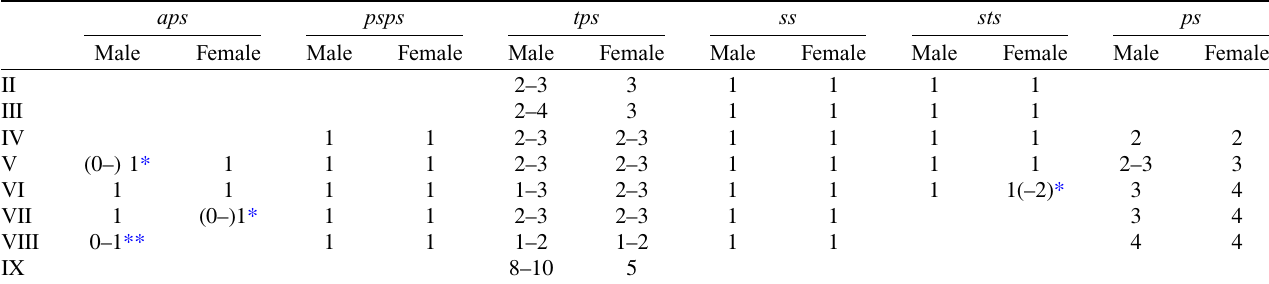
Table 2. Chaetotaxy of one side of abdominal segments II – IX of male and female of Sturnidoecus from Turdus merula collected in the Azores, 2013 . Trichoid setae of segment VIII are present in all specimens, and are not listed. Abbreviations: aps = accessory post-spiracular seta; psps = principal post-spiracular seta; ps = paratergal seta; ss = sutural seta; sts = sternal seta; tps = tergal posterior